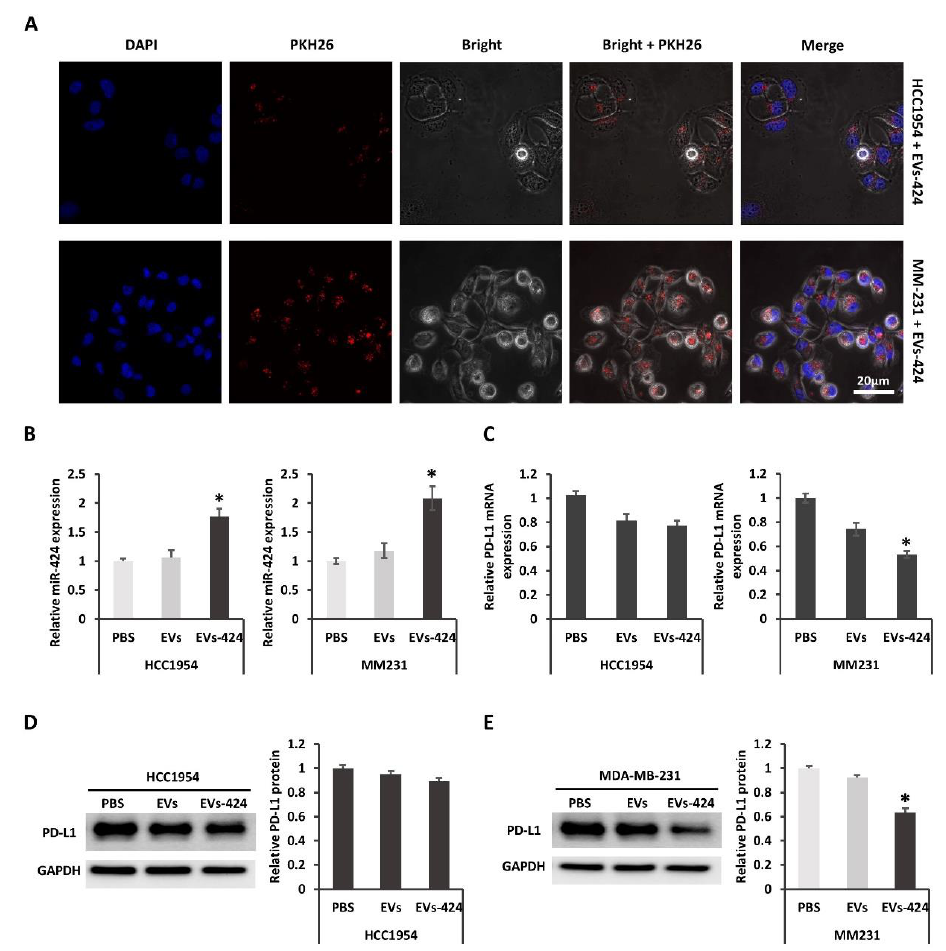
Figure 4. PD-L1 was downregulated by miR-424-5p delivered via EVs. ( A ) The internalization of EVs into MM231 (upper) and HCC1954 (bottom) cells 24 h after incubation. Scale bar: 20 µ m. ( B ) Relative expression of miR-424-5p in recipient HCC1954 and MM231 were determined via qRT-PCR assay 24 h after EV incubation. ( C ) Relative mRNA expression of PD-L1 in HCC1954 and MM231 cells was determined via qRT-PCR assay 24 h after EV incubation. PD-L1 protein expression in HCC1954 ( D ) and MM231 cells ( E ) was compared by Western blotting 48 h after treatment. * p <